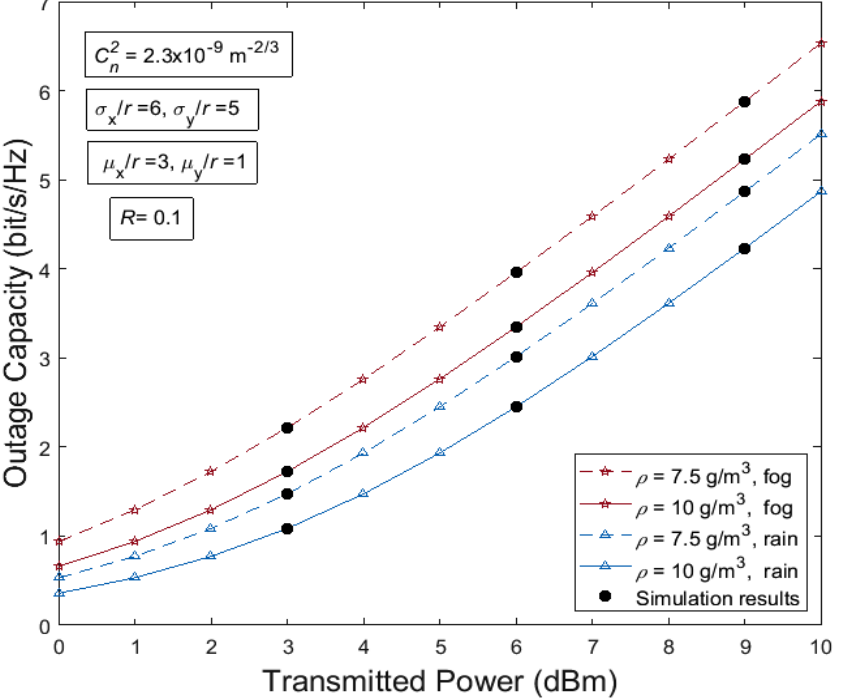
Figure 3. Outage capacity (C out /B) versus transmitted power, strong turbulence, moderate to strong water vapor concentration, weak NZB PE, and R = 0.1. water vapor concentration, weak NZB PE, and R =